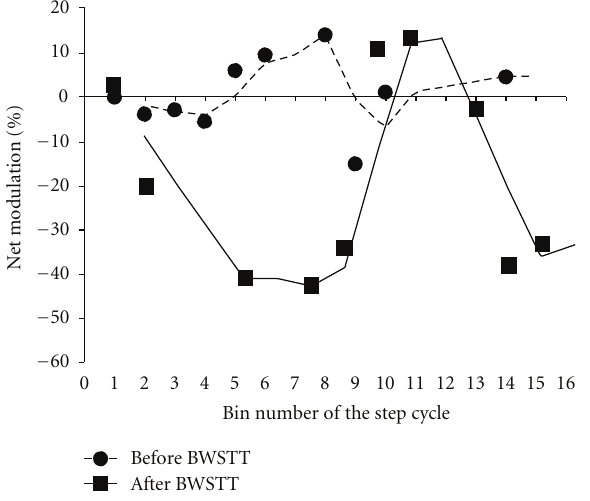
Figure 5: Changes in the cortical control of reciprocal Ia inhibition after locomotor training in SCI. Net e ff ects of subthreshold tran- scranial magnetic stimulation (TMS) on reciprocal Ia inhibition during BWS assisted stepping before and after 60 body weight- supported treadmill training (BWSTT) sessions. The net e ff ects of subthreshold TMS on reciprocal inhibition were estimated at each bin of the step cycle based on the equation ( D - C )-( B - A ) whereas A is the test H-reflex during stepping, B is the soleus H-reflex conditioned by subthreshold TMS during stepping at a conditioning-test (C-T) interval of 1ms, C is the soleus H-reflex conditioned by common peroneal nerve stimulation (i.e., reciprocal inhibition) at a C-T interval of 3 ms during stepping, and D is the reciprocal inhibition conditioned by subthreshold TMS (3 and 1ms C-T intervals). Positive values indicate potentiation of reciprocal inhibition and negative values indicate attenuation of reciprocal inhibition by cortical